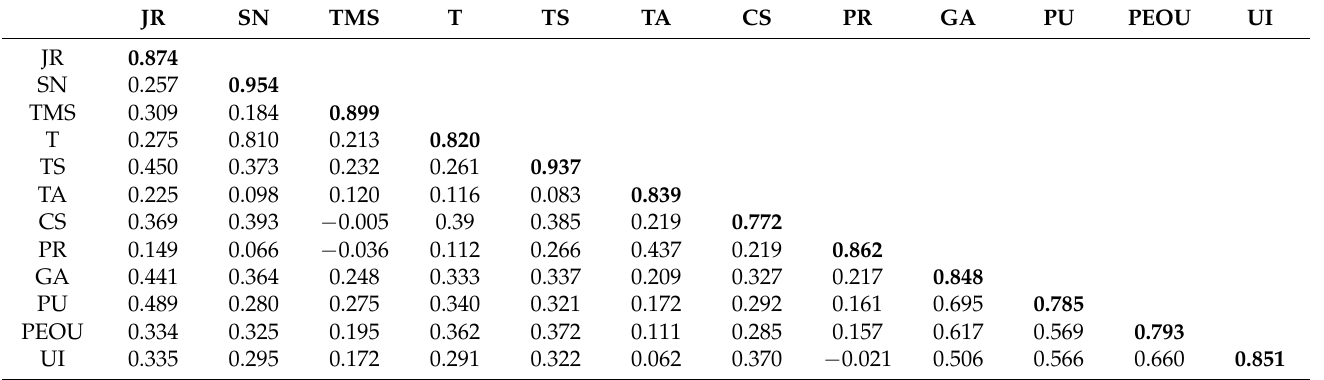
Table 4. Pearson correlation coefficients.